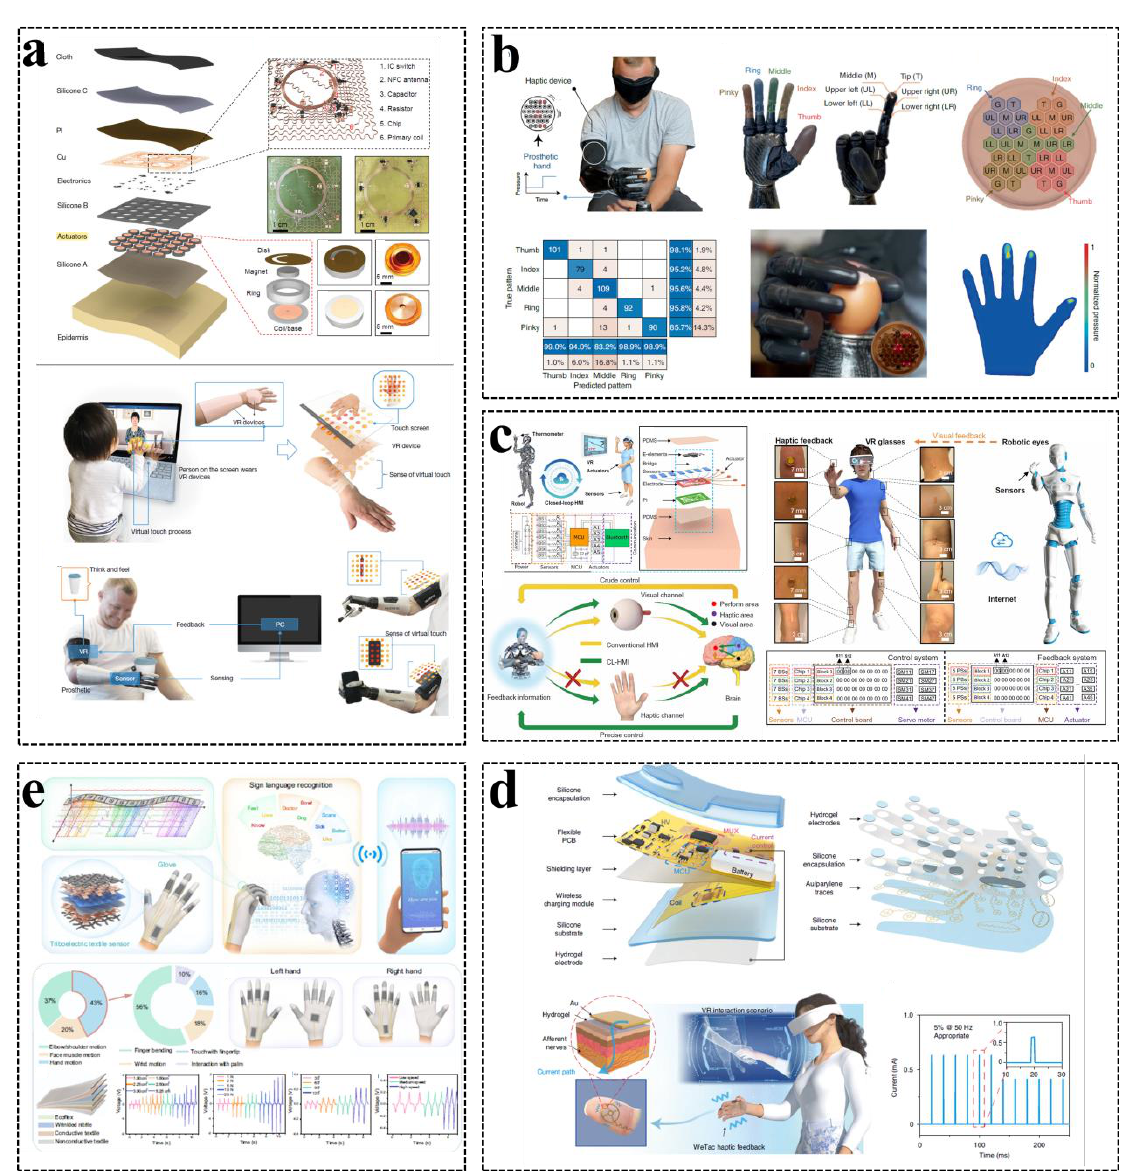
Figure 8. HMI for virtual/augmented reality applications: ( a ) Skin-integrated wireless HMI and feedback systems for AR/VR application. Reproduced with permission [147], Copyright 2019, Springer Nature. ( b ) Tactile interface as a sensory substitution for robot hand control feedback. Reproduced with permission [18], Copyright 2022, Springer Nature. ( c ) The closed-loop HMI in robotic VR applications. Reproduced with permission [9], Copyright 2022, American Association for the Advancement of Science. ( d ) A miniaturized wireless tactile system for personalized feedback with virtual objects. Reproduced with permission [148], Copyright 2022, Springer Nature. ( e ) A triboelectric smart glove for sign language recognition and VR communication. Reproduced with permission [149], Copyright 2021, Springer Nature.